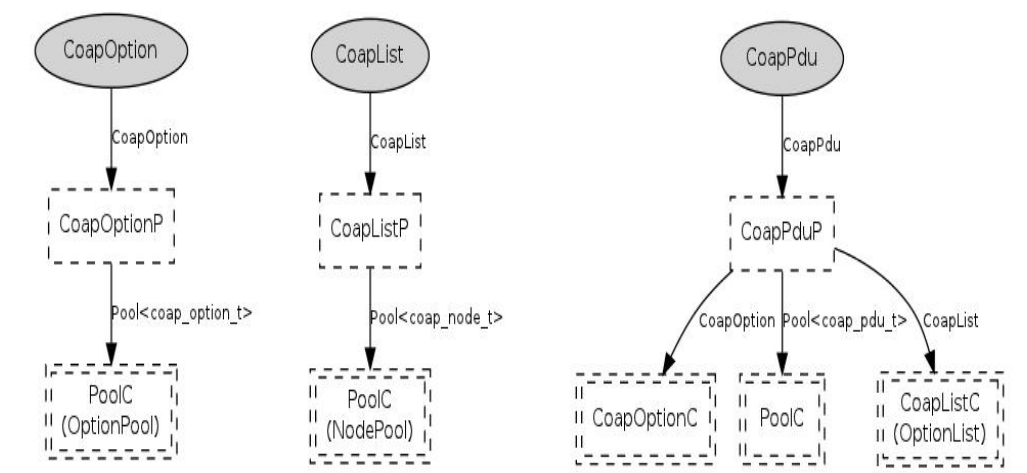
Figure 4. Wiring of the TinyCoAP interface for the CoAP message layer. PoolC is used to provide the memory needed by the